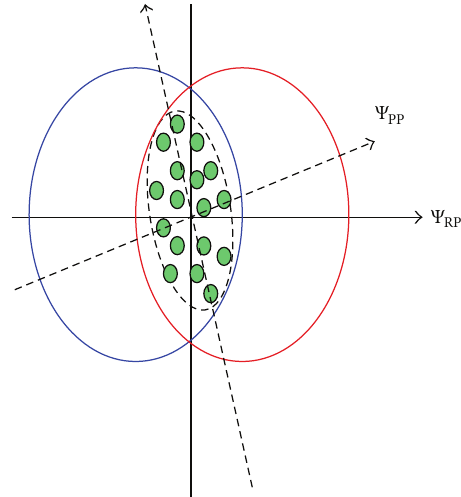
Figure12:Aschematicrepresentationfordistributionofparticipant nucleons on the transverse plane in Au+Au collisions in a Monte- ) is tilted with respect Carlo event. The participant plane angle (𝜓 PP ) to the reaction plane (𝜓 RP